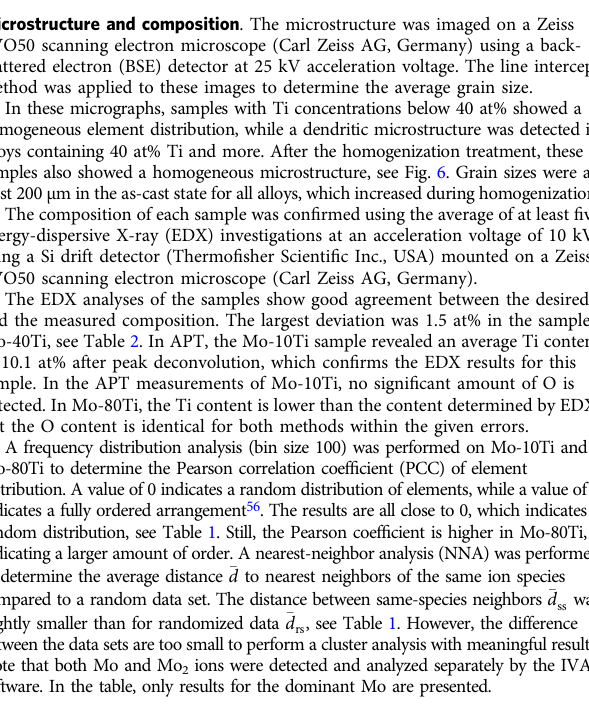
Fig. 7 Correlations between mechanical properties. Correlation graphs between the Vickers hardness H (horizontal axis) and σ p5 (black squares, left axis) and H and nanohardness nH (blue triangles, right ð 10 Þ